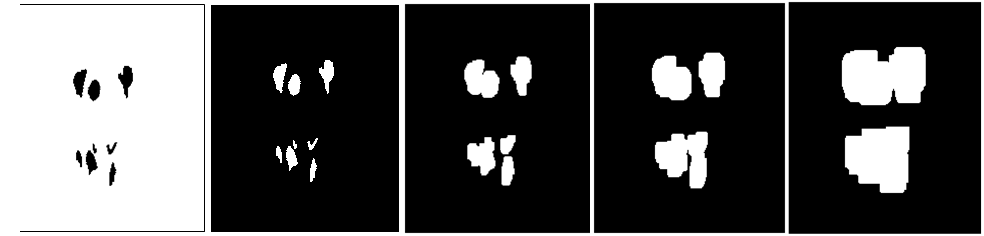
Figure A2. Multi-level distance